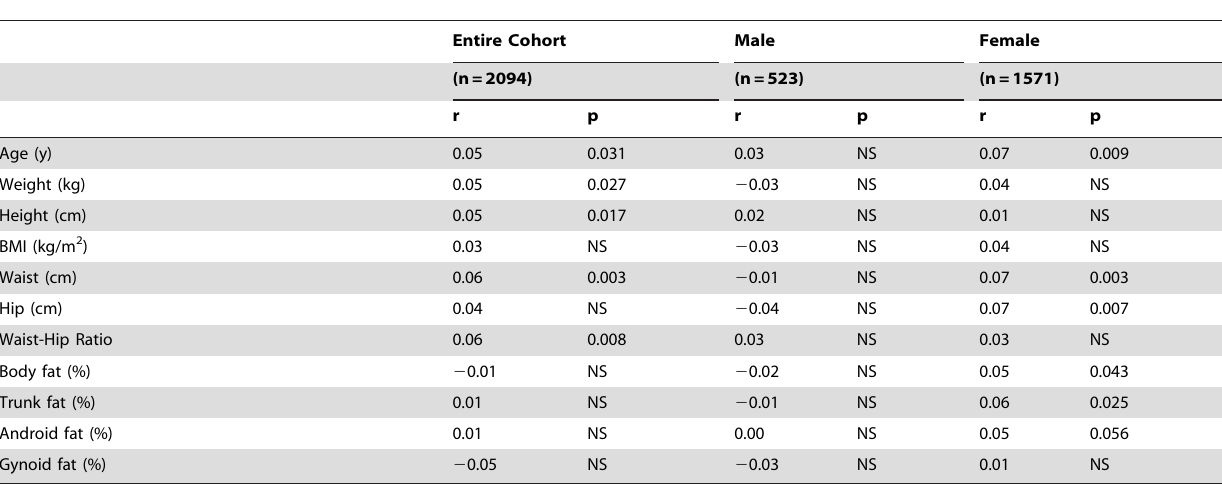
Table 2. Pearson correlation of body composition measurements with circulating PYY 1,2 .